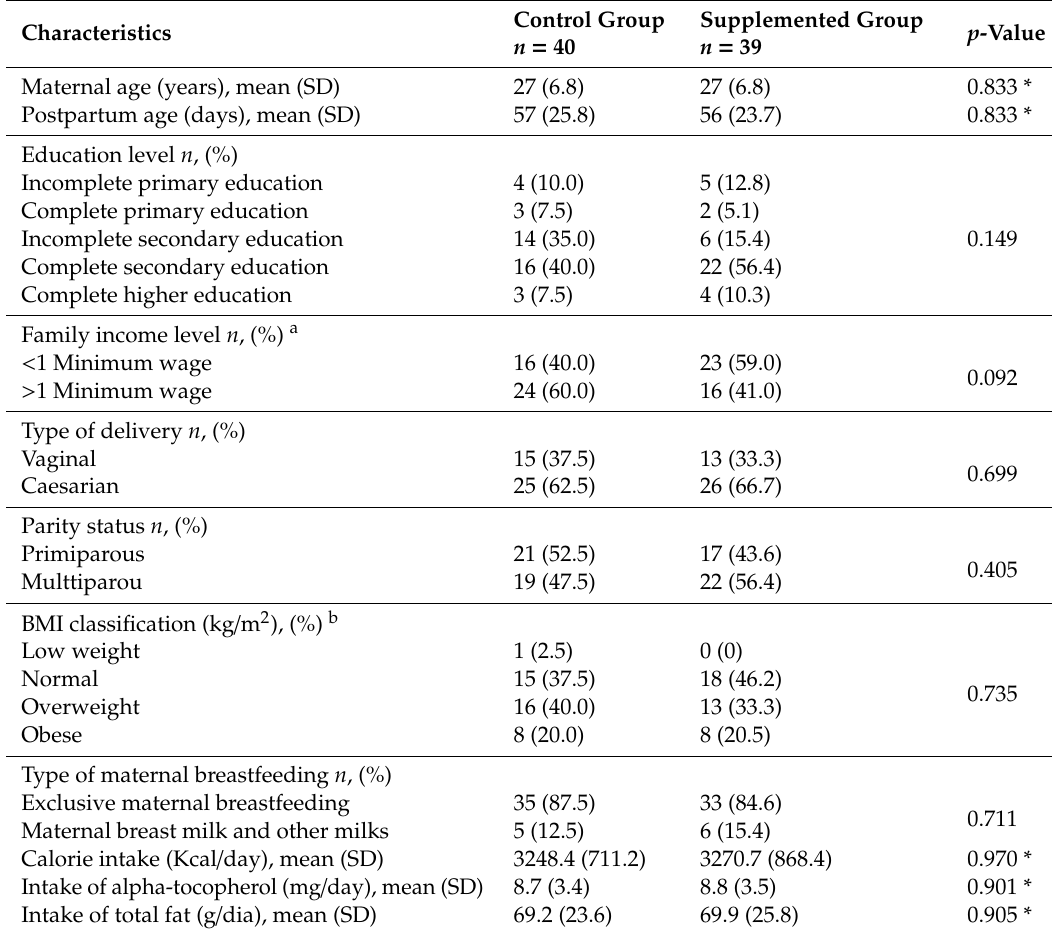
Table 1. Characterization of the 79 lactating women randomized into the control and supplemented groups of the study. Natal, Rio Grande do Norte, Brazil,